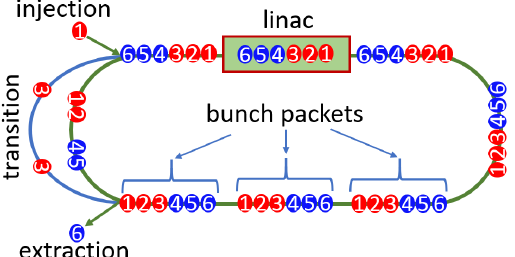
FIG. 1. Intrapacket blocks. rf cycles are shown within the linac. Each block is colored differently. The red/blue bunches are on the peak/trough and being accelerated/decelerated.